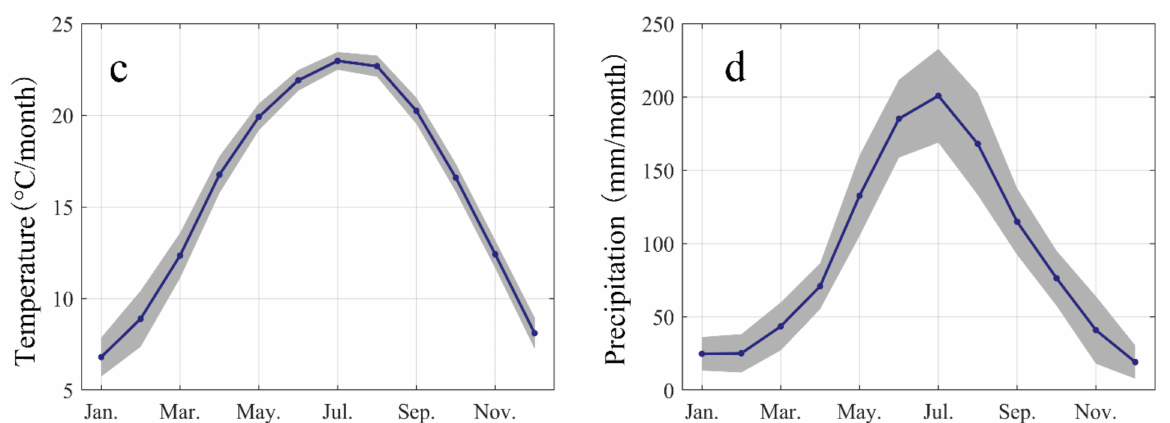
Figure 1. Altitude, land cover, and climatic conditions of SWC. ( a ) Altitude; ( b ) land cover types, 1–6 represent cropland, forest, grassland, water, built–up land, and unused land, respectively; ( c , d ) seasonal cycles of monthly temperature and precipitation during 1982–2019. The curved lines indicate the monthly averages, with standard deviations indicated by the shaded grey areas.